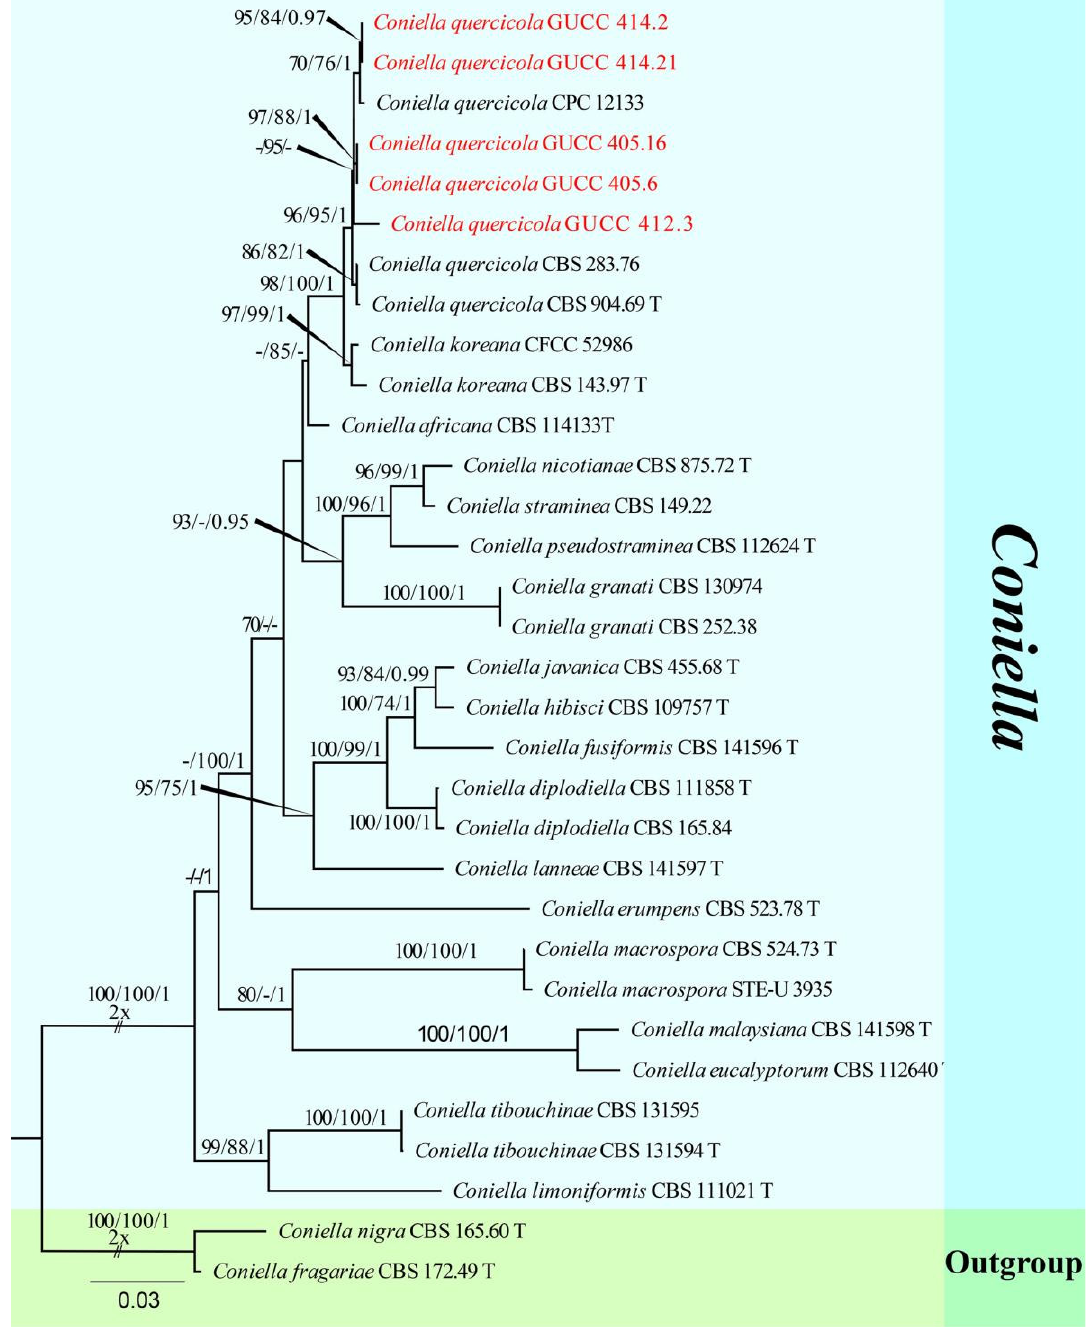
Figure 14. Phylogram generated from RAxML analysis of a concatenated ITS-LSU- tef1 sequence dataset to represent the phylogenetic relationships of taxa in Coniella . The tree was rooted with C. fragariae (CBS 172.49, ex-type strain) and C. nigra (CBS 165.60, ex-type strain). Bootstrap support values for ML and MP equal to or greater than 70% and the Bayesian posterior probabilities equal to or higher than 0.95 PP are indicated above the nodes as ML/MP/PP. Support values lower than 70% ML/MP and 0.95 PP are indicated by a hyphen (-). The newly generated sequences are indicated in red.